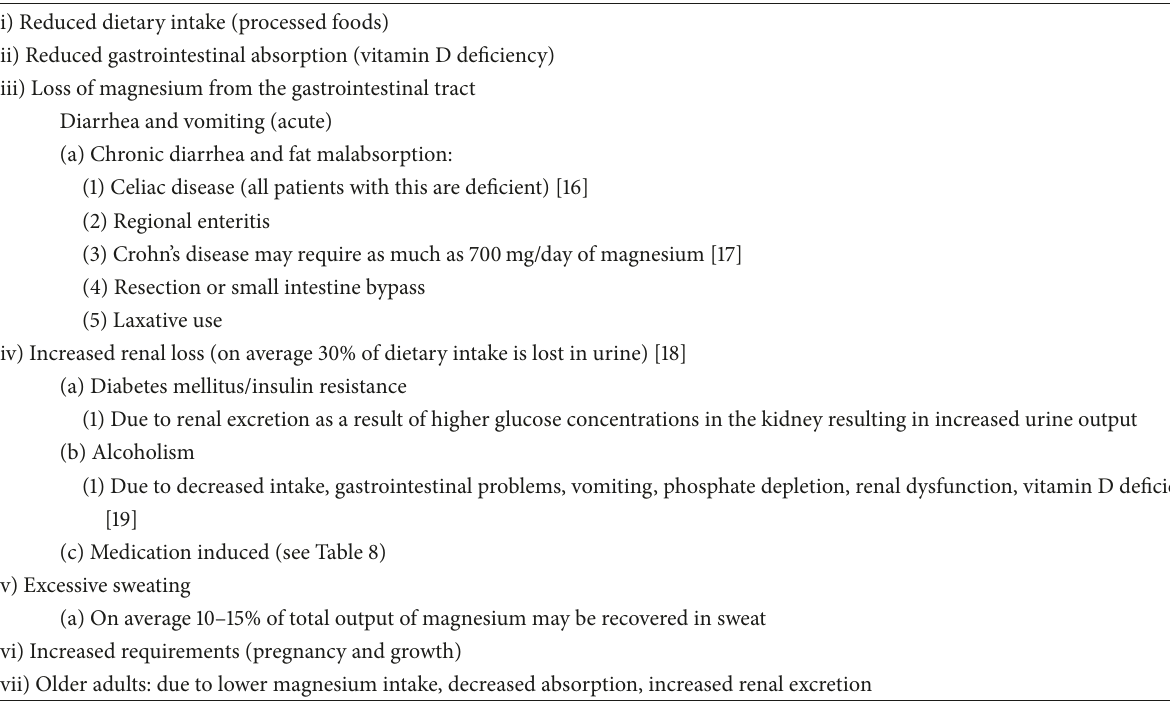
Table 5: Etiology of magnesium deficiency [6].